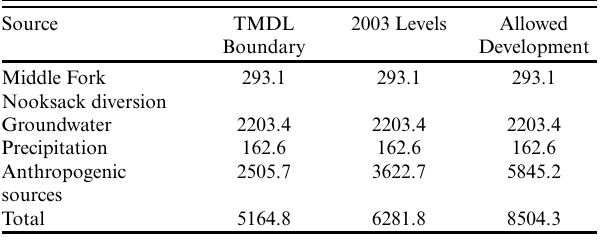
Table 5 . Phosphorous influxes (kg/yr) to Lake Whatcom: total maximum daily load (TMDL) boundary, 2003 values, and projection under full development allowed under 2003 zoning regulations. Values were derived from Pickett and Hood